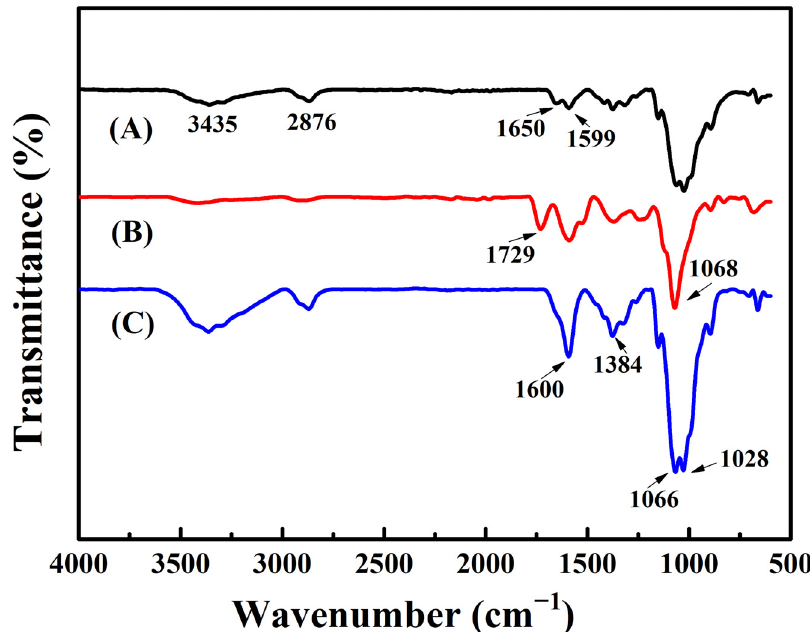
Figure 1. Attenuated total reflectance Fourier transform infrared (ATR-FTIR) spectra of ( A ) chitosan (CS), ( B ) chitosan tartaric ester (CS-TA) and ( C ) chitosan tartaric sodium (CS-TA-Na).